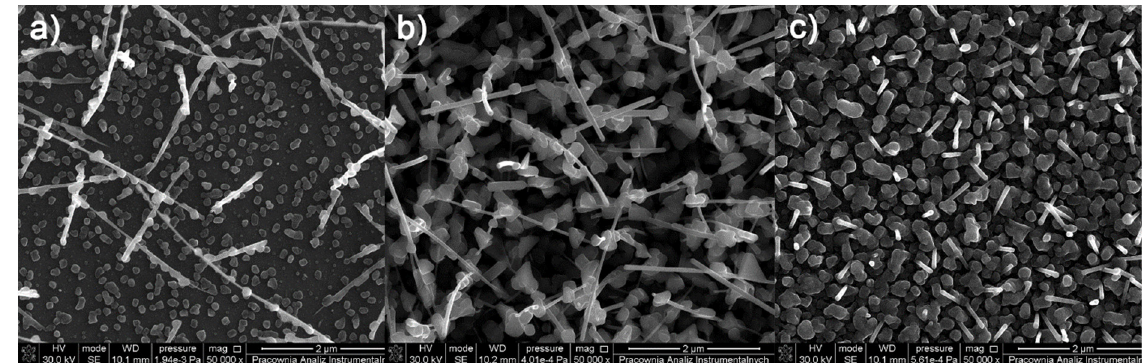
Figure 10. SEM pictures of deposits for the precursor [Cu 2 ( i PrNH 2 ) 2 (µ-O 2 CC 2 F 5 ) 4 ] ( 8 ), Mag = 50,000×, (( a – c )—orderly with the increasing transport pathway), T V = 473 K, T D = 713 K, Si(111), Ar.